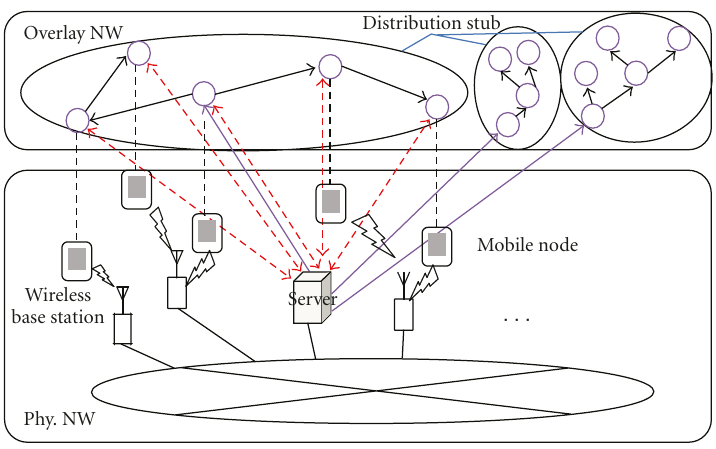
Figure 1: Hybrid structure for P2P mobile multicast. Unidirectional solid lines and bidirectional dashed lines represent stream flows and control messages,